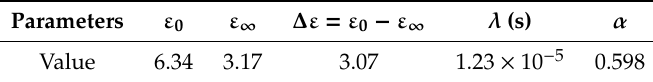
Figure 12. Dielectric properties: ( a ) dielectric constant (square) and loss factor (triangular) vs. frequency and ( b ) loss factor vs. dielectric constant for the PDPA/Fe 3 O 4 -based ER fluid (10 vol%, 50 cSt silicone oil). Solid lines were drawn from Cole − Cole equation. Table 2. Fitted parameters of Cole − Cole equation for PDPA/Fe 3 O 4 -based ER fluid (10 vol%, 50 cSt silicone oil).